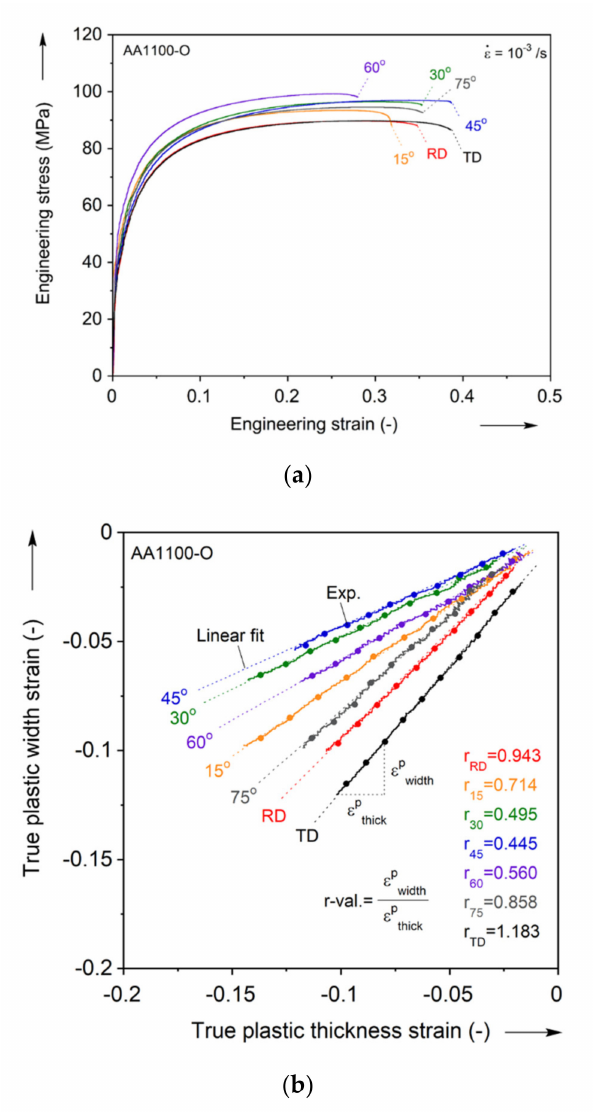
Figure 3. Experiment for uniaxial tension in every 15 ◦ from the RD: ( a ) engineering stress-strain curves and ( b ) linear fitting for r-values